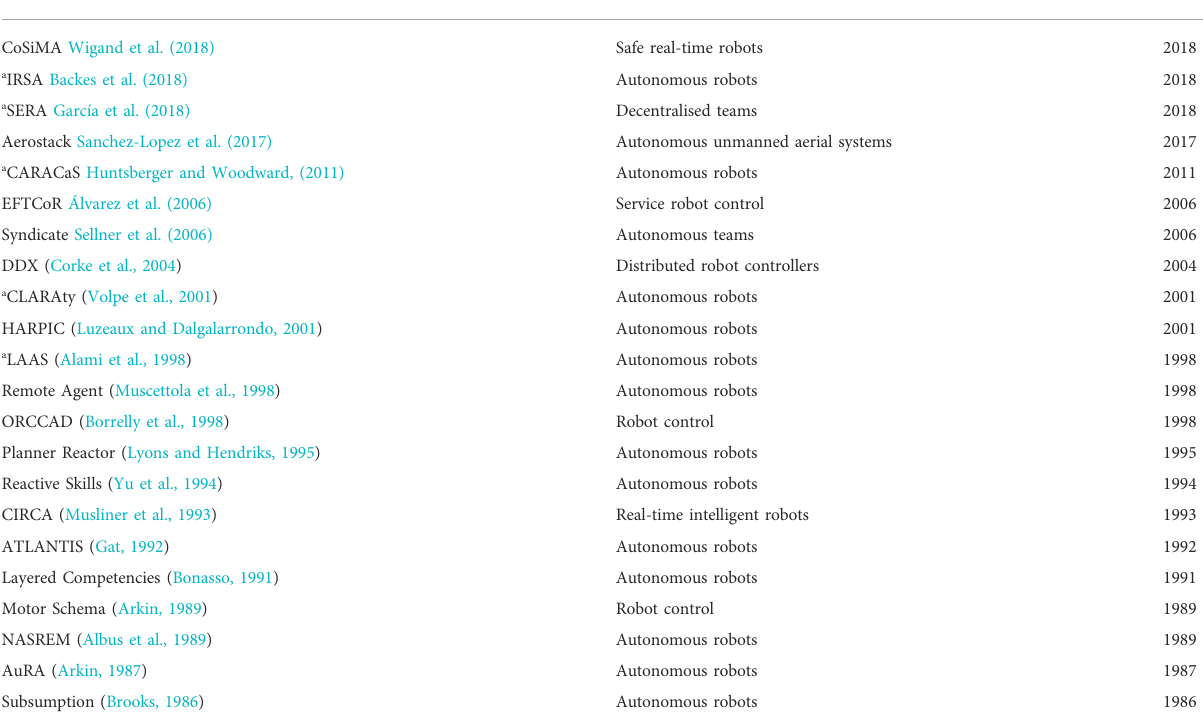
TABLE 1 The patterns identi fi ed from the literature.